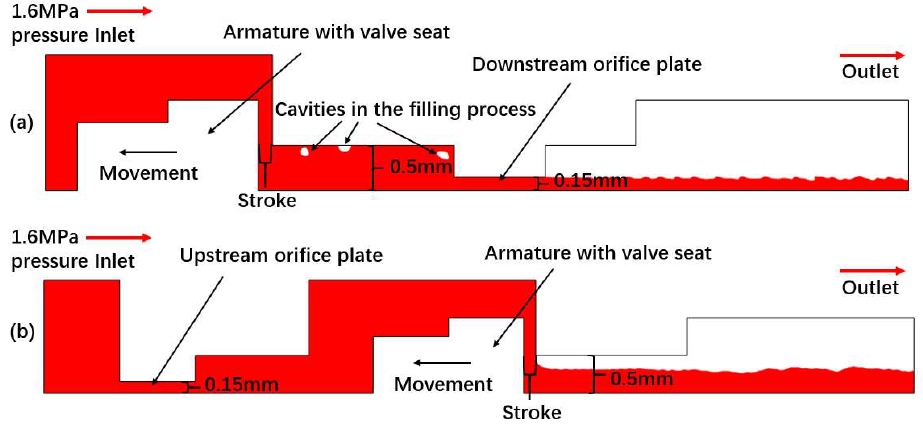
Figure 2. Simulation domains of valve simulation with downstream orifice plate ( a ) and upstream orifice plate ( b ).